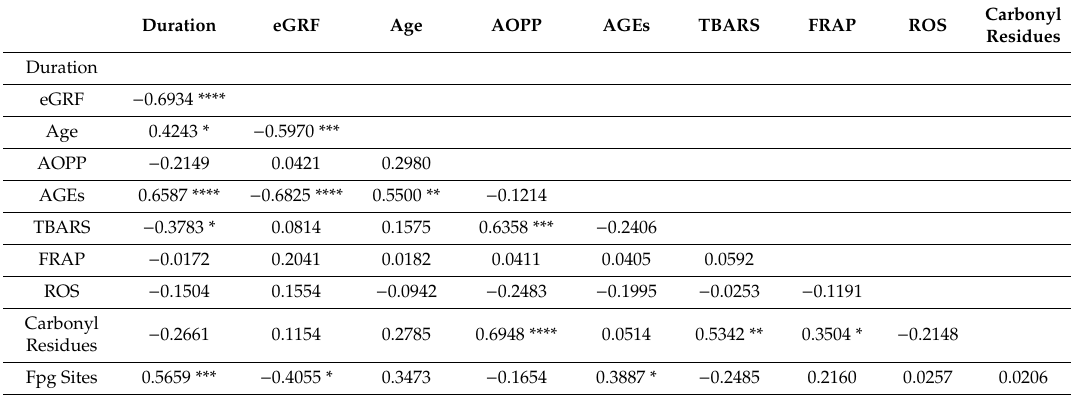
Table 2. Correlations between changes in oxidative stress-related biomarkers, duration of diabetes, eGRF and the age of the